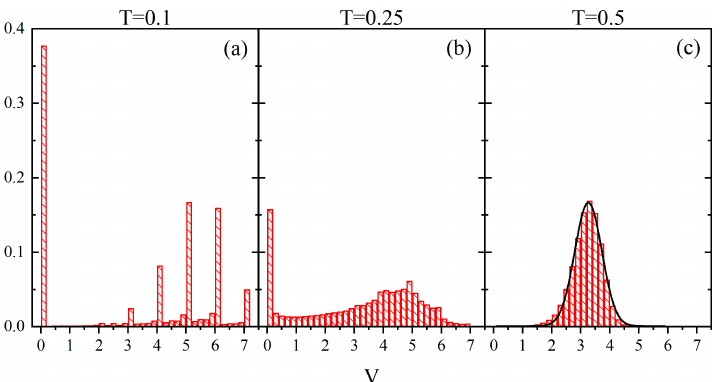
Figure 6. Normalized probability density ρ ( V ( (cid:126) r )) for T = 0.1 ( a ), T = 0.25 ( b ) and T = 0.5 ( c ). Solid line ( T = 0.5) represents gaussian